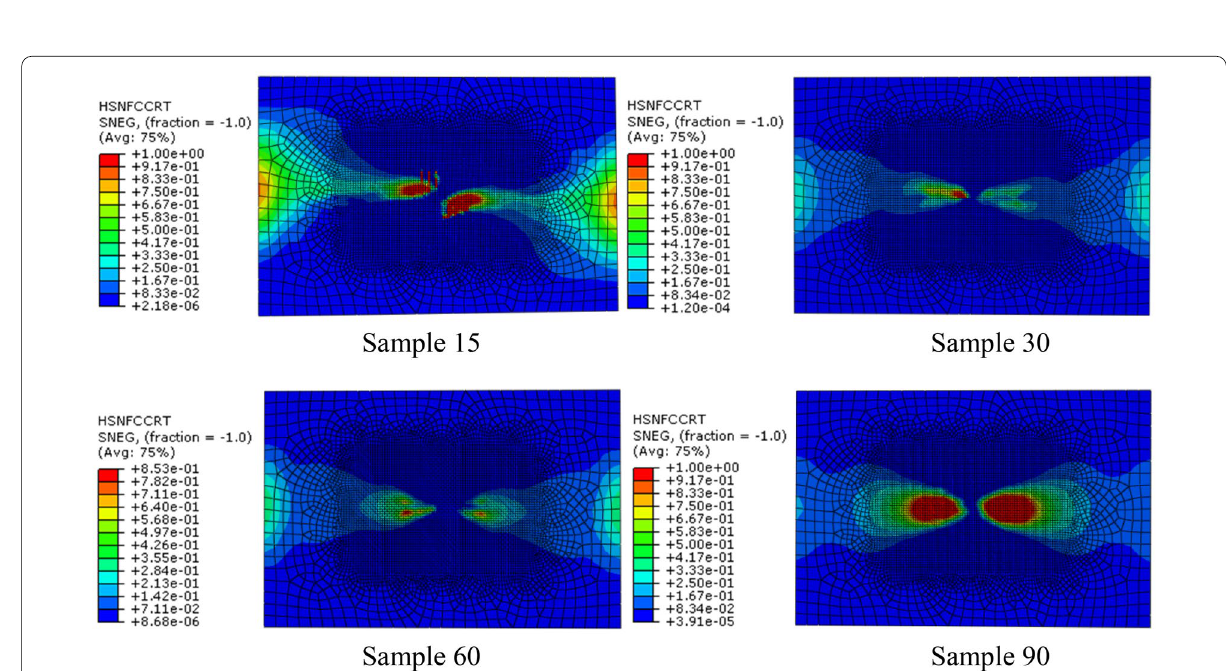
Fig. 5 Distribution nephogram of fiber compression failure of four bionic models with different helix angles when impact energy is 20